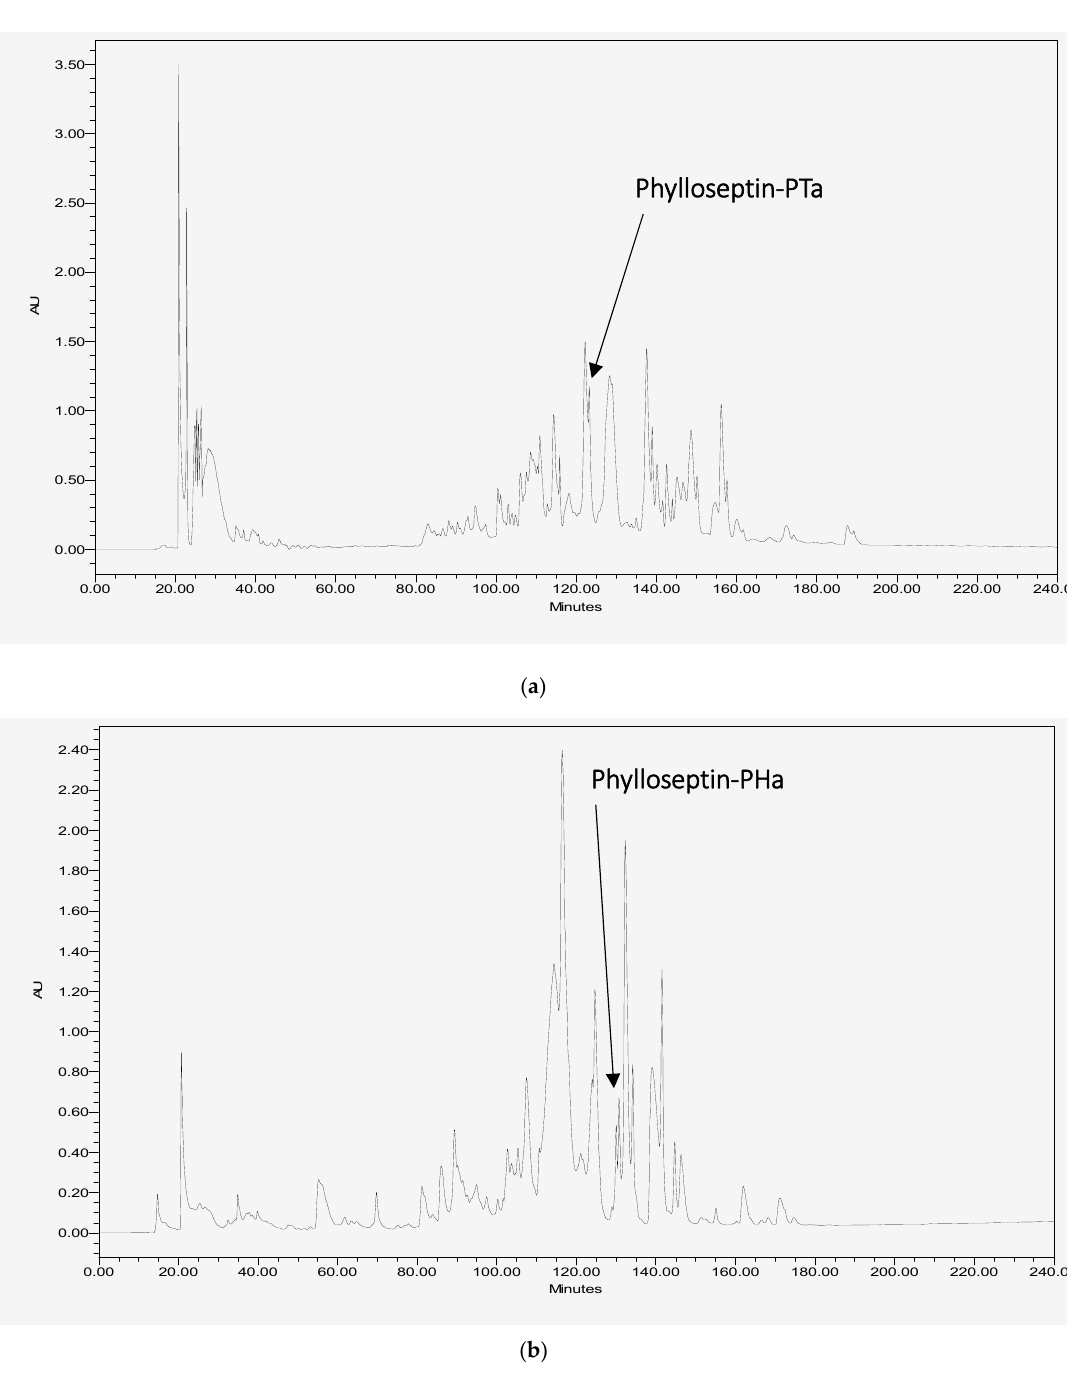
Figure 3. Reversed-phase high performance liquid chromatography (RP-HPLC) chromatograms of the skin secretions from ( a ) P. tarsius and ( b ) P. hypochondrialis with arrows showing the absorbance peaks corresponding to mature phylloseptin-PTa and phylloseptin-PHa, respectively. The Y -axis shows the relative absorbance in absorbance units at a wavelength of 214 nm and the X -axis shows the retention time in minutes.